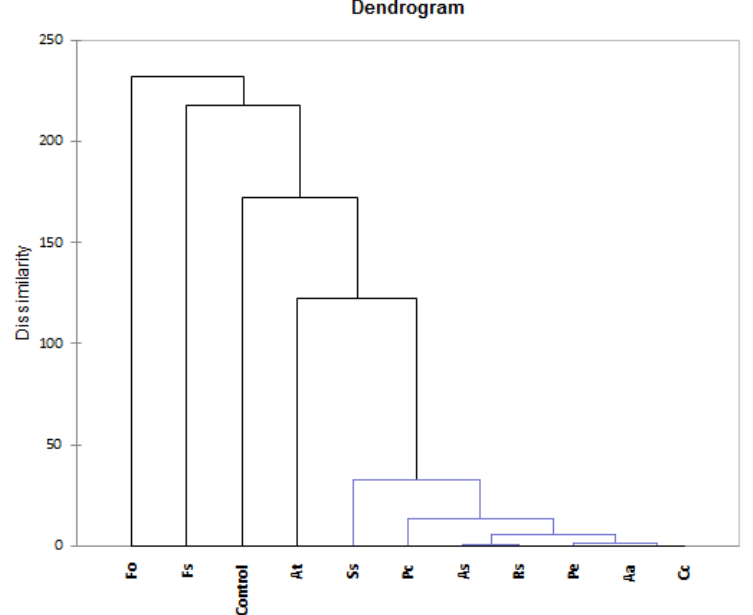
Figure 2. Dendrogram from the hierarchical clustering analysis (HCA). Fo— F. oxysporum ; Fs— F. sambucinum ; Aa— A. alternata ; As— A. solani ; At— A. tenuissima ; Rs— R. solani ; Cc— C. coccodes ; Pe— P. exigua ; Ss— S. scabiei ; Pc— P. carotovorum .